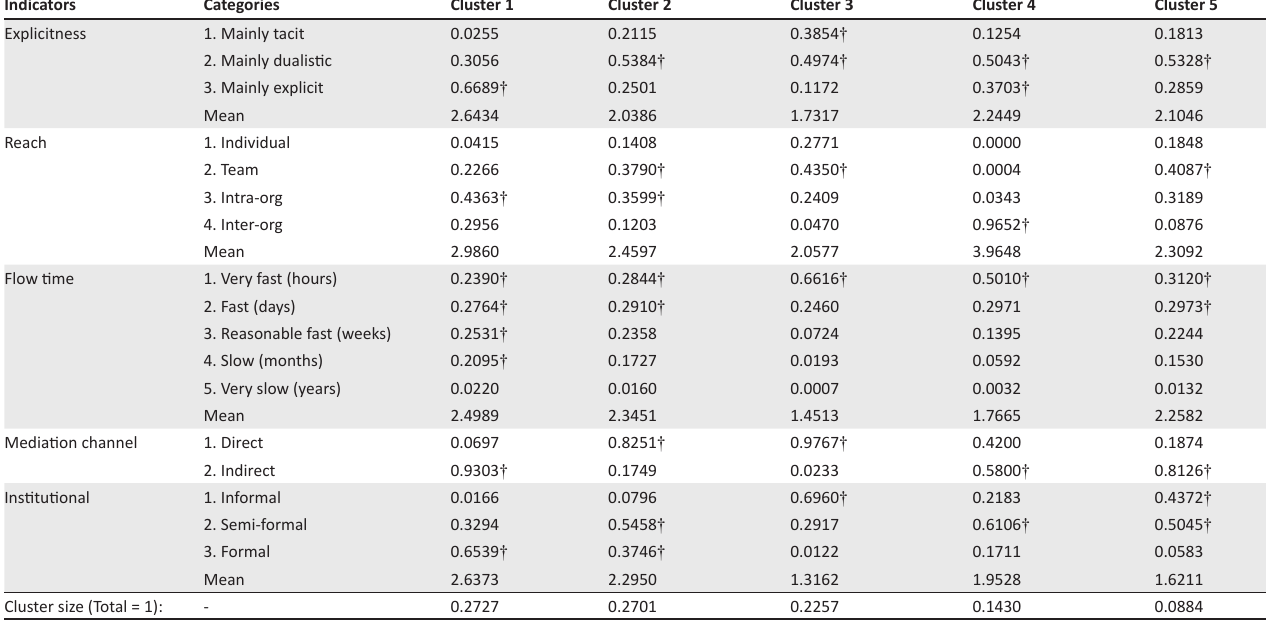
TABLE 9: Profile table.